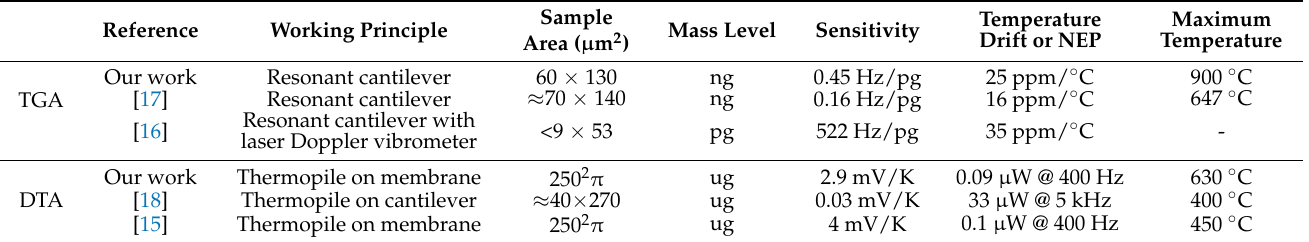
Table 1. Performance comparison between micro-TGA and micro-DTA.